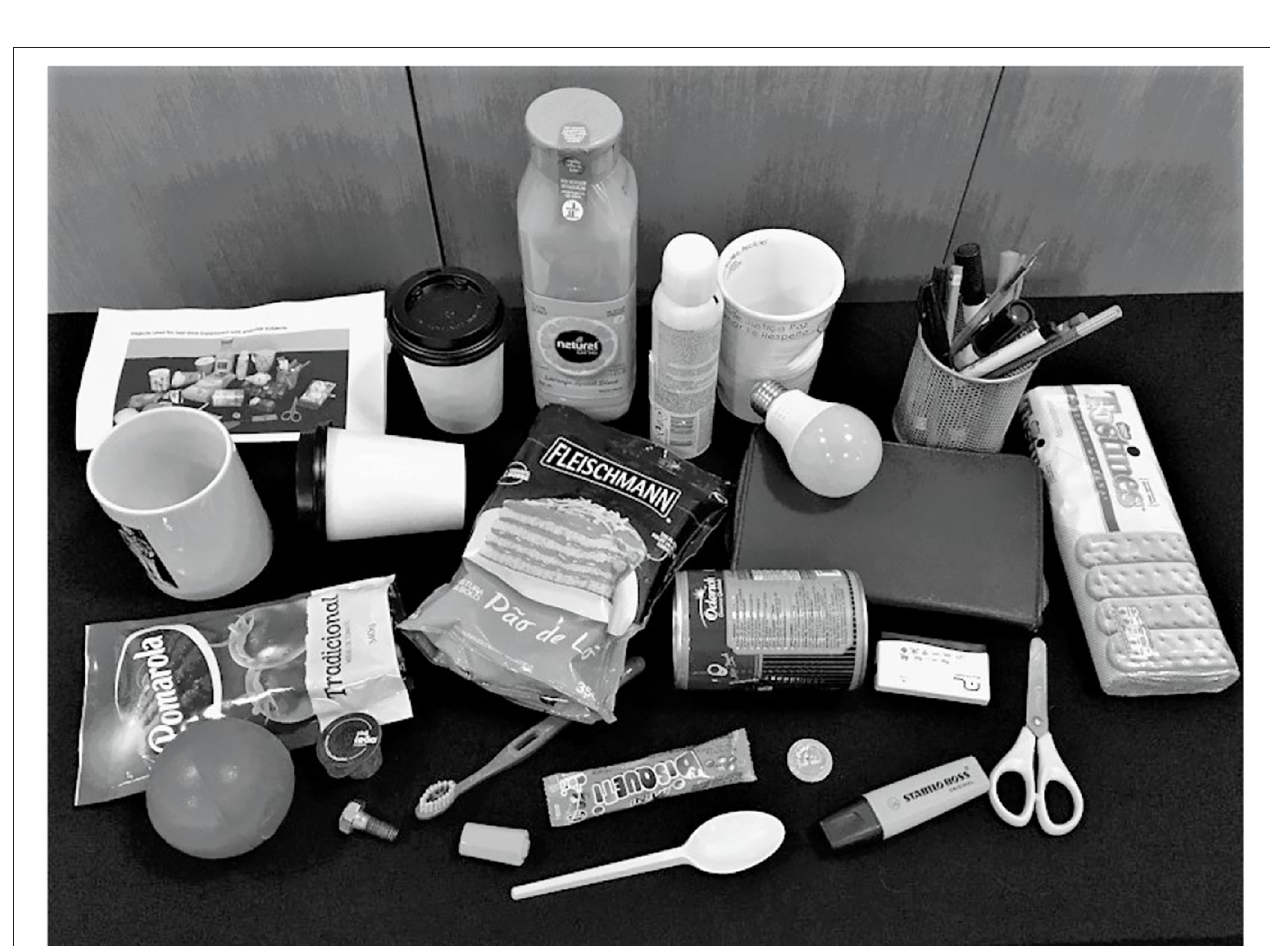
FIGURE 4 | Objects used for comparison between